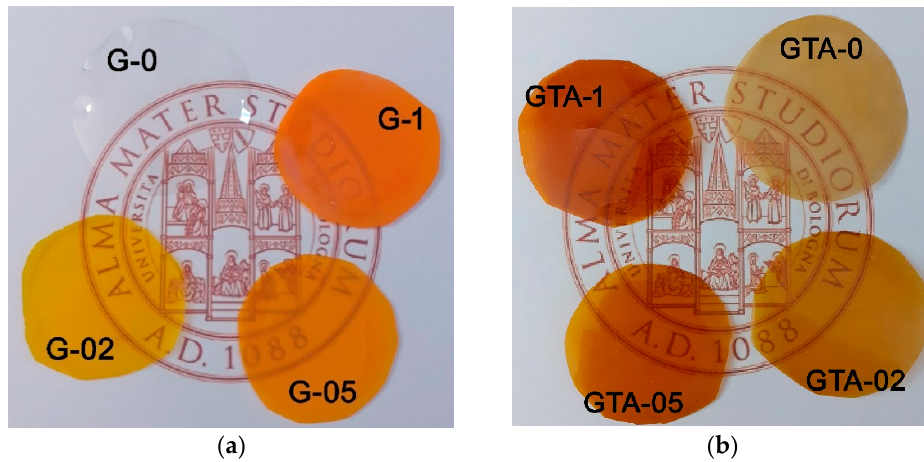
Figure 2. Photographs of films at different curcumin content made from ( a ) gelatin and curcumin; ( b ) gelatin, curcumin and crosslinked with glutaraldehyde solution.